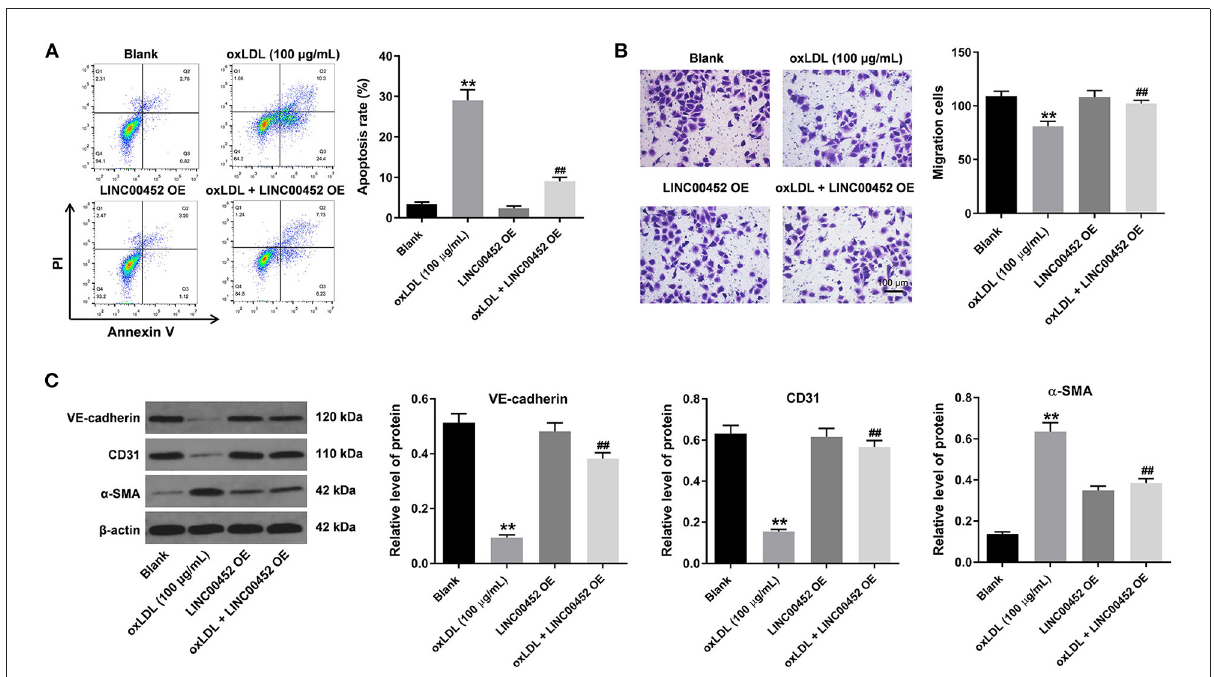
FIGURE2 LINC00452 overexpression reverses oxLDL-induced apoptosis, migration and EndMT process of HUVECs. HUVECs were treated with oxLDL (100 µ g/mL) for 24h. Next, HUVECs were transfected with pcDNA3.1-LINC00452 using Lipofectamine 2000 for 24h. (A) Flow cytometry assay was performed to detect the apoptosis of HUVECs. (B) Transwell assay was performed to detect the migration of HUVECs. (C) Western blot assay was performed to detect the expressions of α -SMA, CD31 and VE-cadherin in HUVECs. β -actin was used for normalization. ** P <